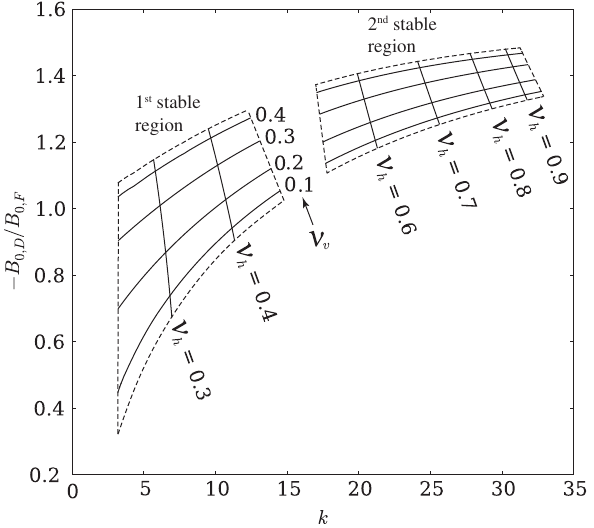
FIG. 4. Parameter space which was studied for the NORMA ring lattice. The region encapsulating stable lattices is shown by a dashed area and the horizontal ν h and vertical ν v cell tunes are shown with solid lines. The first and second stability region of Hill ’ s equation are indicated; separated by the half-integer cell tune.